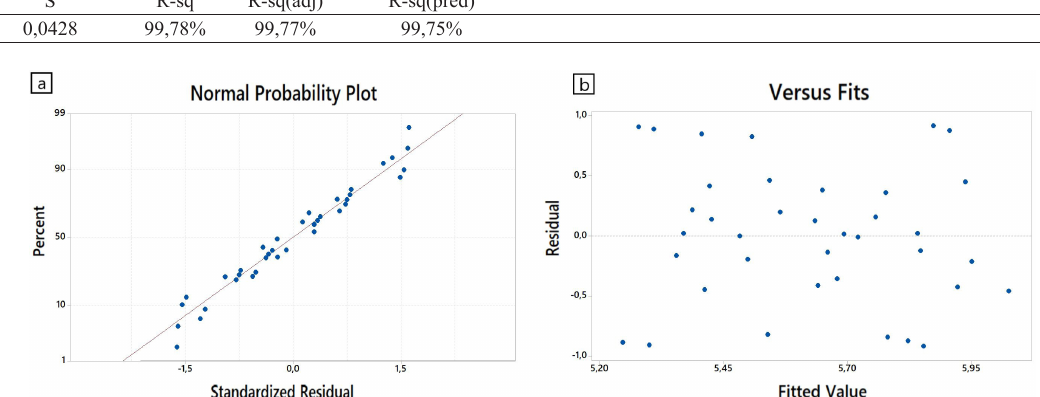
Figure 8. Residual plots analysis for ANOVA treatment